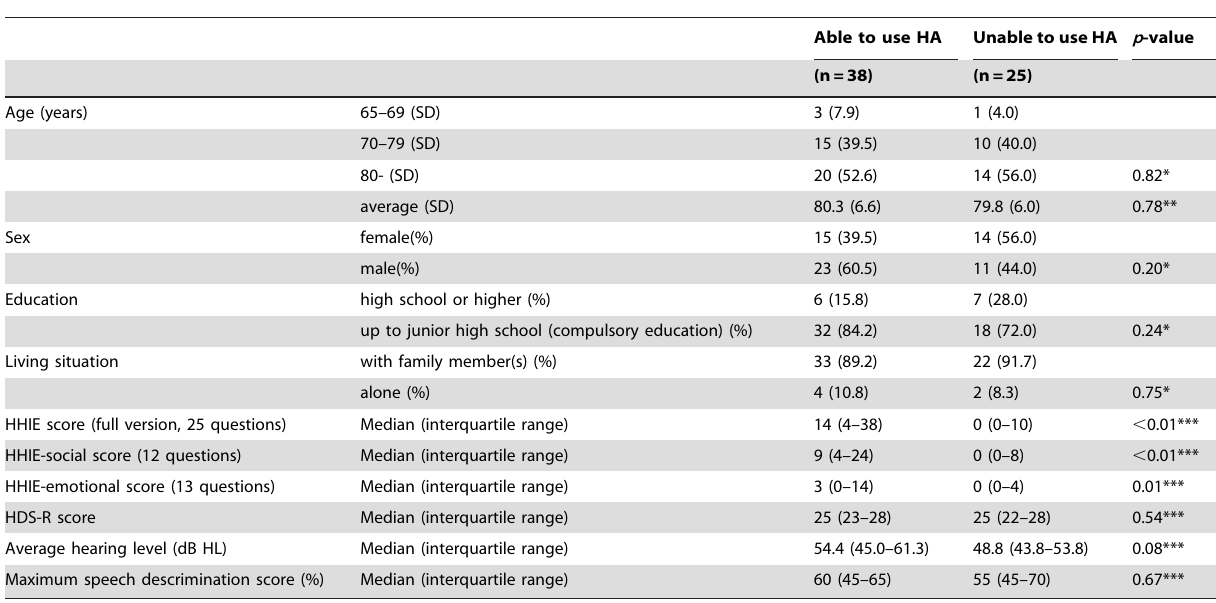
Table 3. Baseline characteristics of study participants according to hearing-aid usage.